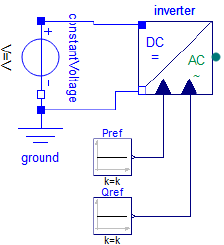
Figure A8. Modelica’s photovoltaic (PV) model.